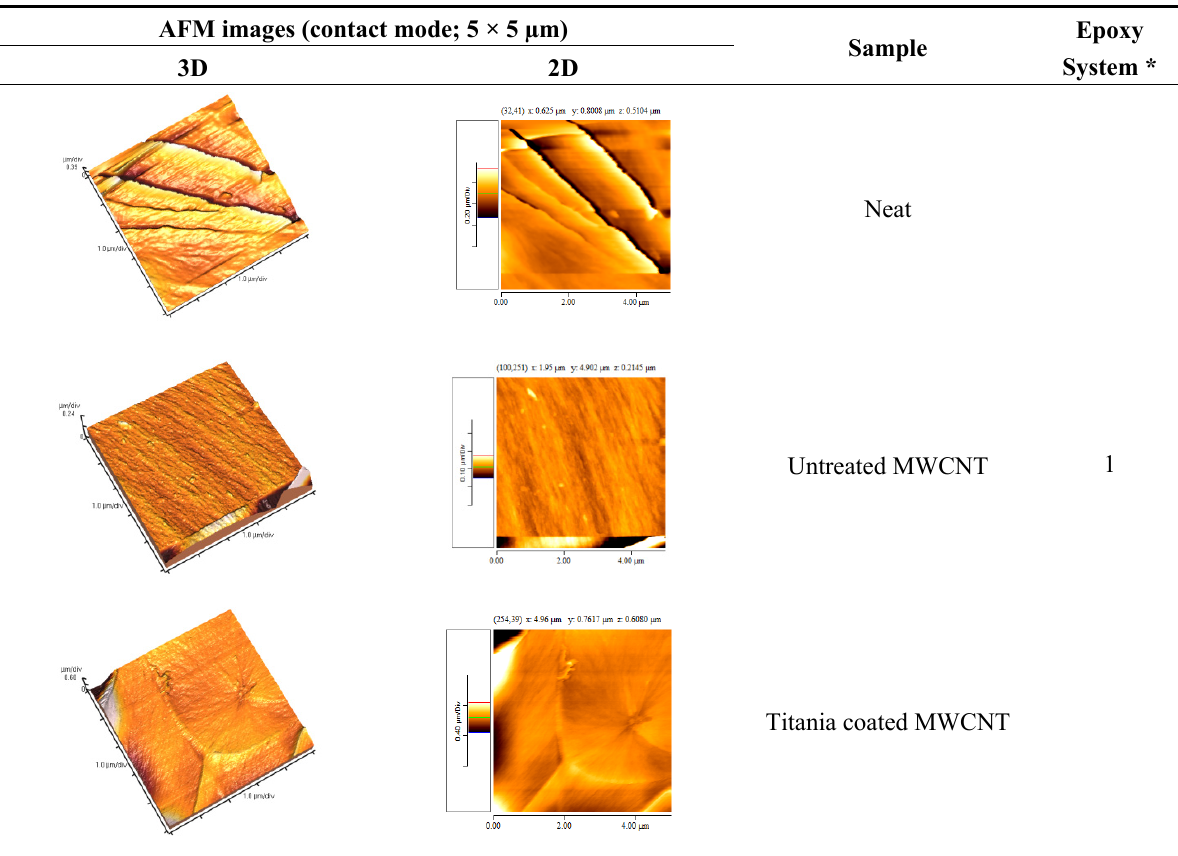
Table 8. AFM images of fractured surface morphologies of nanocomposites contain 0.3 wt %